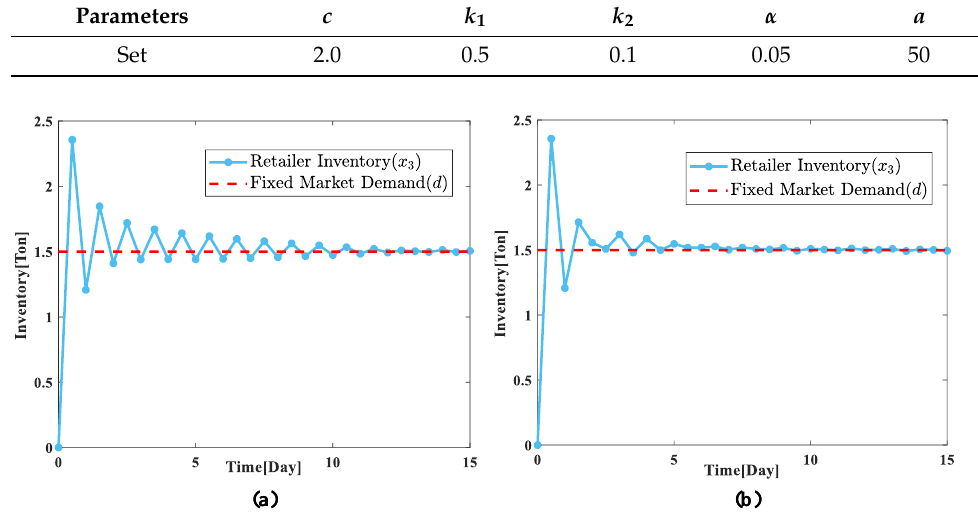
Figure 8. Diagram of the change in retailer’s inventory before and after parameter adjustment. ( a ) Initial parameters; ( b ) optimization